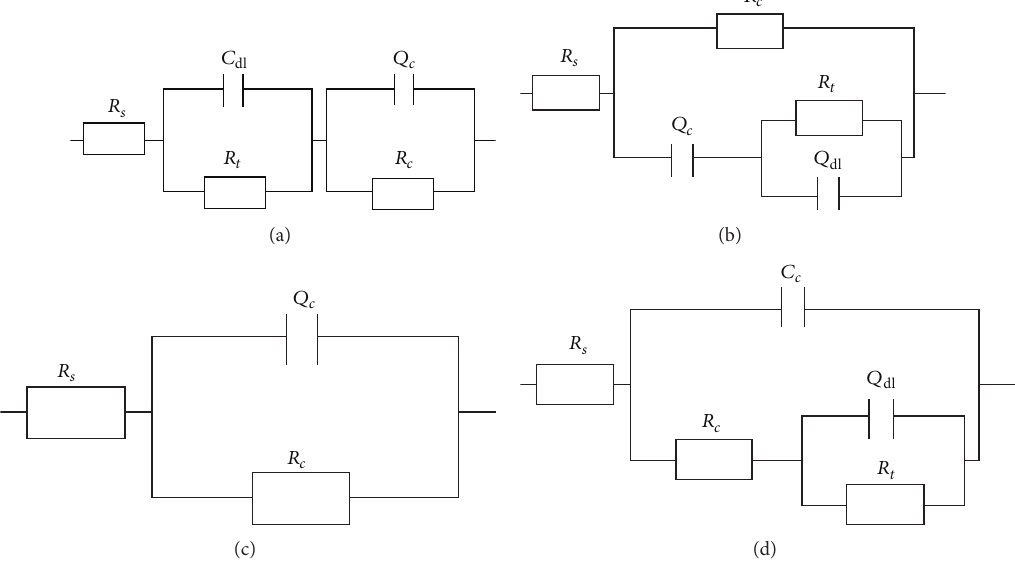
Figure 6: Equivalent circuit representing the coating